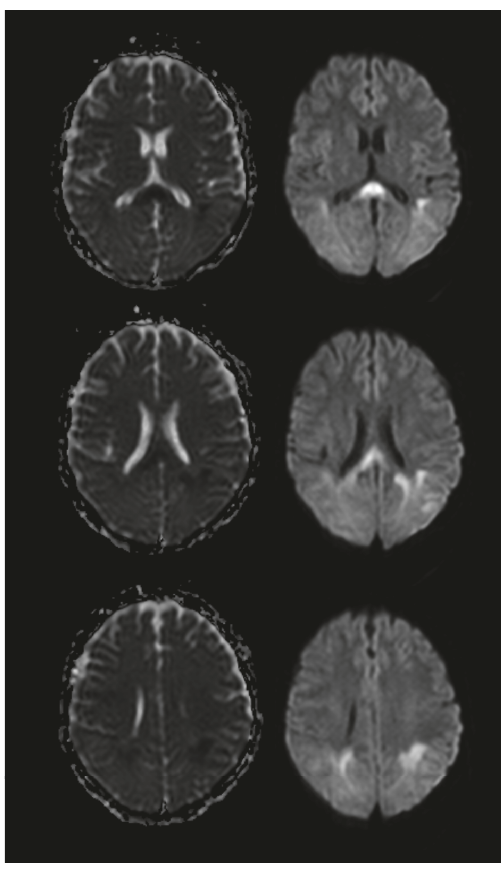
Figure2:DW/ADCmapseriesshowingpatchydiffusionrestriction in posterior parietal sections as well as splenial segment of corpus